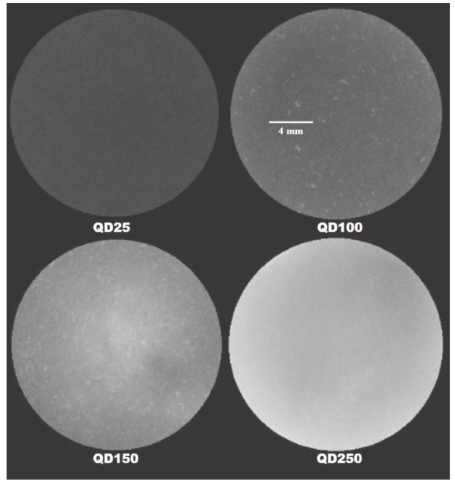
Figure 4. X-ray imaging of the four compound